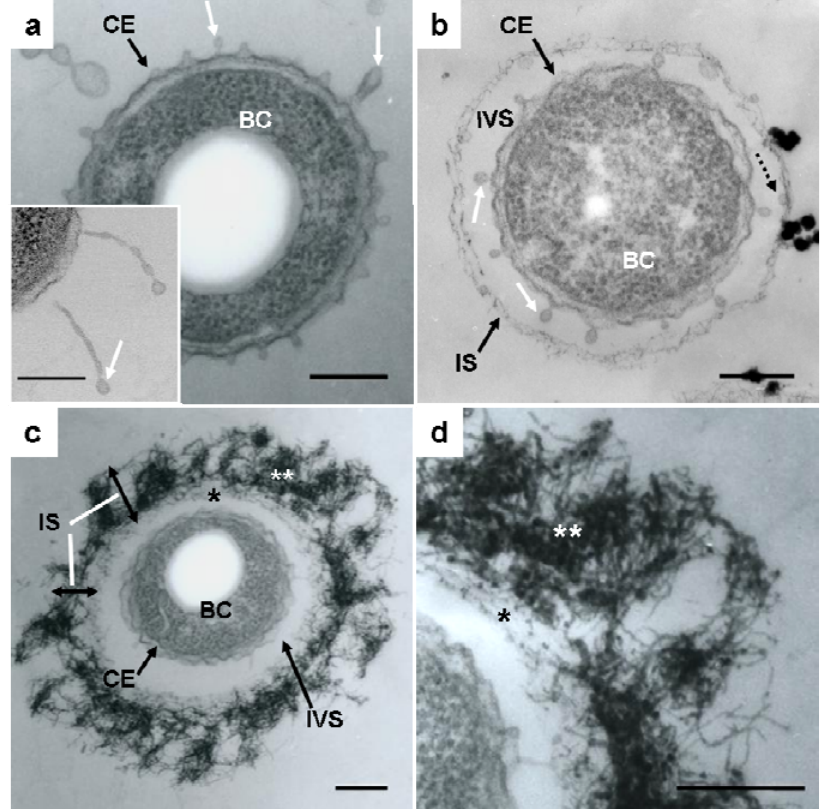
Figure 1. TEM and STEM images of OUMS1 and associated structures in U/Pb-stained cross sections. ( a ) Bacterial cell surrounded by a cell envelope in a one-day-old culture. The immature sheath layer has not yet formed. White arrows: globular projections from the surface of the cell envelope. Inset (STEM image): thread-type projections measuring ca. 300–400 nm in length with a swollen tip; ( b ) A cell and an immature sheath skeleton formed away from the cell, leaving an intervening space (one-day-old culture); ( c ) A cell and associated immature sheath with an inner layer fibril assembly (single star) and an outer layer composed of highly electron dense fibril assembly (double star); ( d ) Enlarged image of a cross section of a bacterial cell in (c). Note that fibrils in the inner layer (single star) are almost aligned in parallel, while those in the outer layer (double star) are fluffy and extremely electron dense, suggesting heavy deposition of aqueous-phase inorganic elements. Scale bars = 200 nm. BC, bacterial cell; CE, cell envelope; IS, immature sheath; IVS, intervening